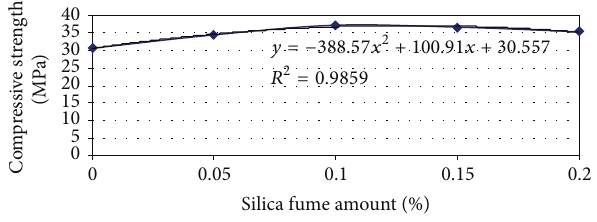
Figure 5: The relation between silica fume additive and compressive strength in concrete with 30/70 fine/large aggregate ratios.